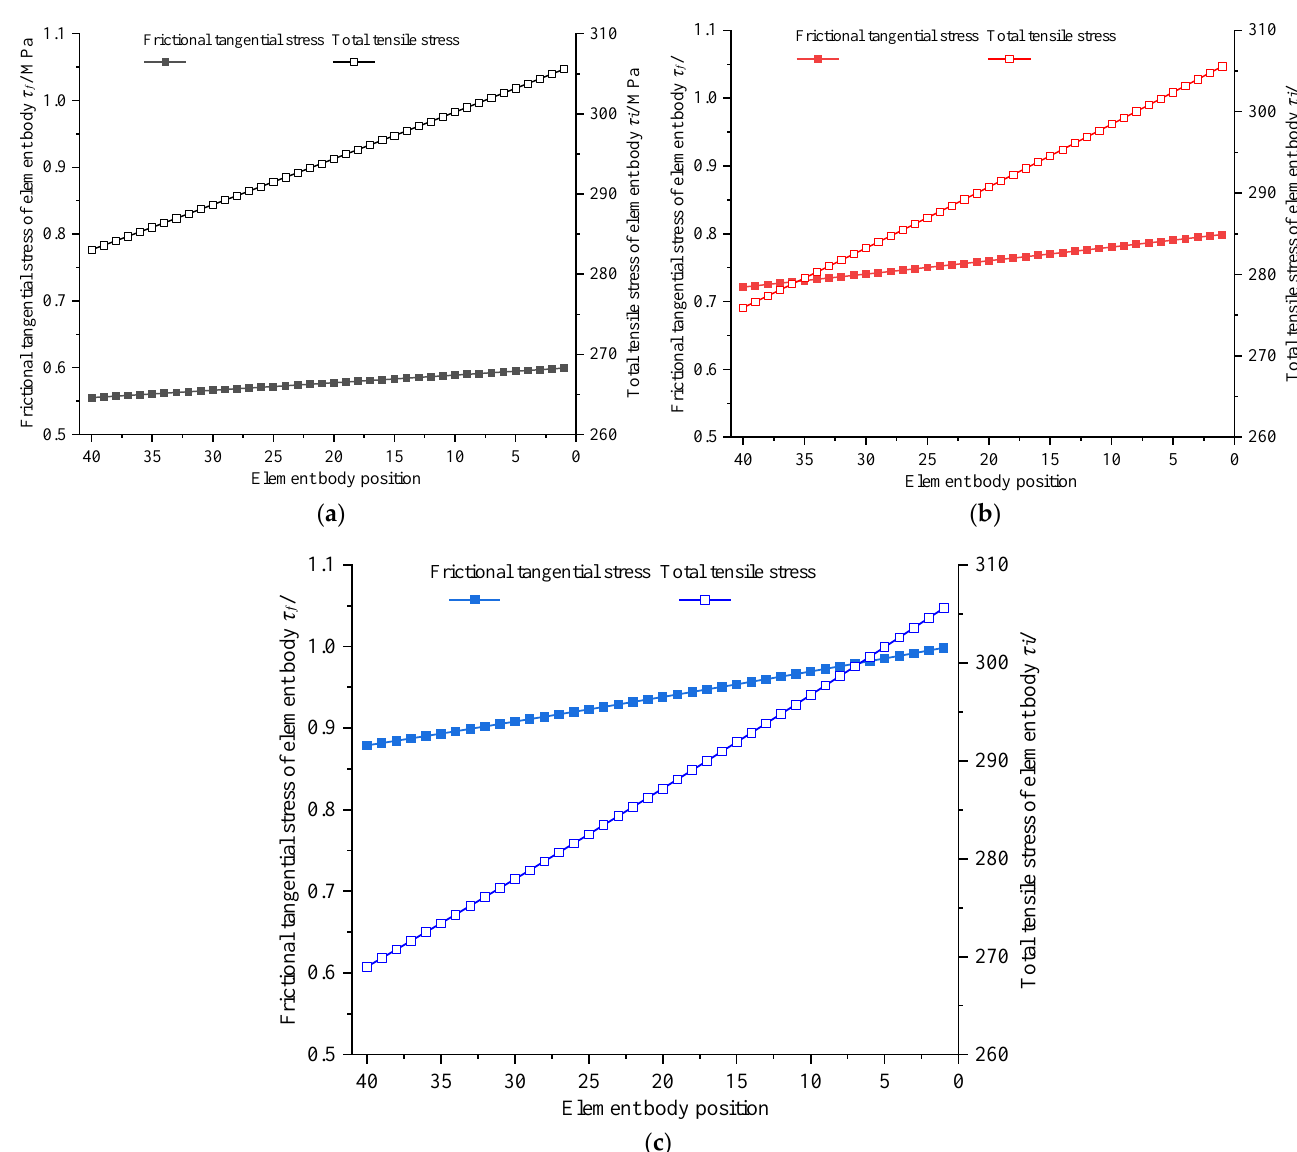
Figure 3. The frictional tangential stress and total tensile stress of each micro-unit under different friction coefficients. ( a ) μ= 0.15; ( b ) μ= 0.2; ( c ) μ= 0.2. It can be seen from Figure 3 that the total tensile stress on the rightmost micro-unit for all three friction coefficients was 305.577 MPa. From right to left along the direction of the bending arc, the total tensile stress experienced by the micro-unit showed a significant decrease. Since the order of frictional shear stress is much smaller than the tensile stress in the micro-unit cross-section, it is known from Equation (5) that the tensile stress in the micro-unit was F i + 1 = F i − F f . The superimposed accumulation of frictional shear stress makes the tensile stress in the bending specimen unevenly distributed.